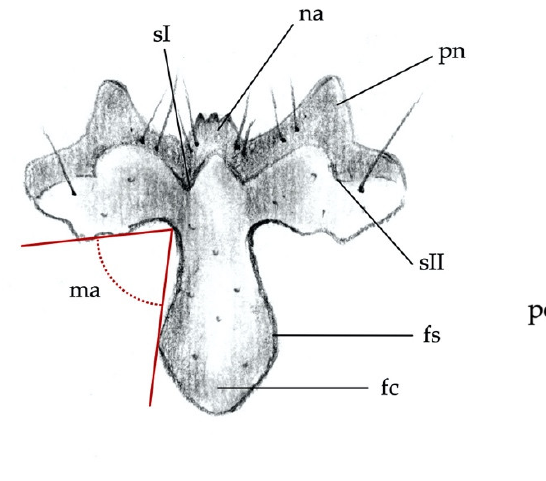
Figure 1. Anatomy of the larva. Dorsal head capsule and 1st thoracic segment: ant, antenna; ep, epicraneal plate; es, stemma; fc, frontoclypeus; fs, frontal suture; md, mandible; mx, maxillary palp; tx, prothorax.